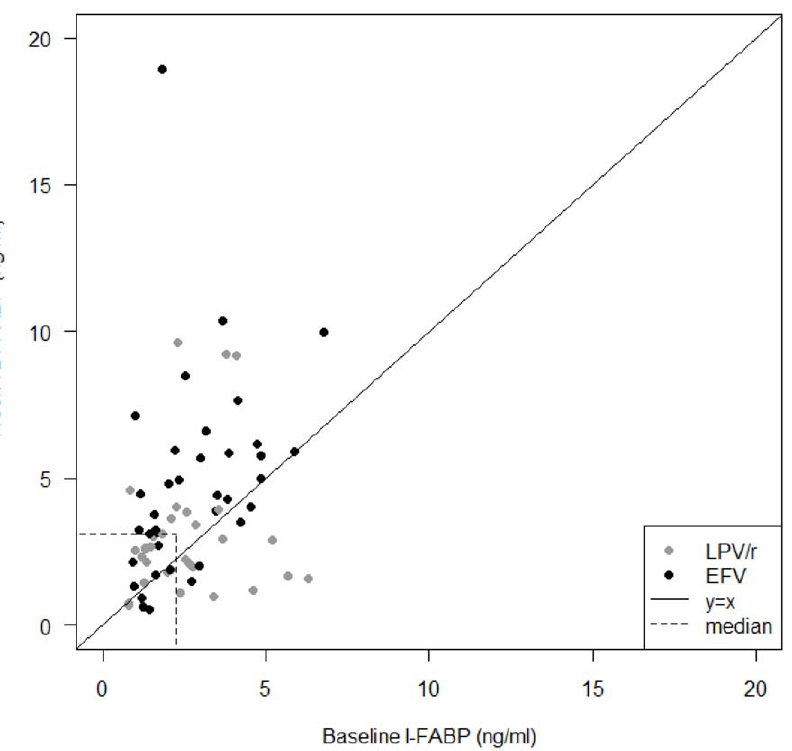
Figure 5. Levels of Intestinal Fatty Acid Binding Protein (I-FABP). Plasma levels of I-FABP were significantly elevated after 72 weeks of antiretroviral treatment as compared to baseline in the whole cohort. Stratified to treatment arms, efavirenz (EFV) treated patients had significantly increased levels , but not the patients on lopinavir/r (LPV/r) therapy. Data are shown as individual values with corresponding baseline I-FABP levels at X-axis and week 72 levels at Y-axis, respectively. Individuals treated with lopinavir (LPV/r) are indicated with shaded and efavirenz (EFV) with black circles. Dotted lines refer to median values at the corresponding time-point.